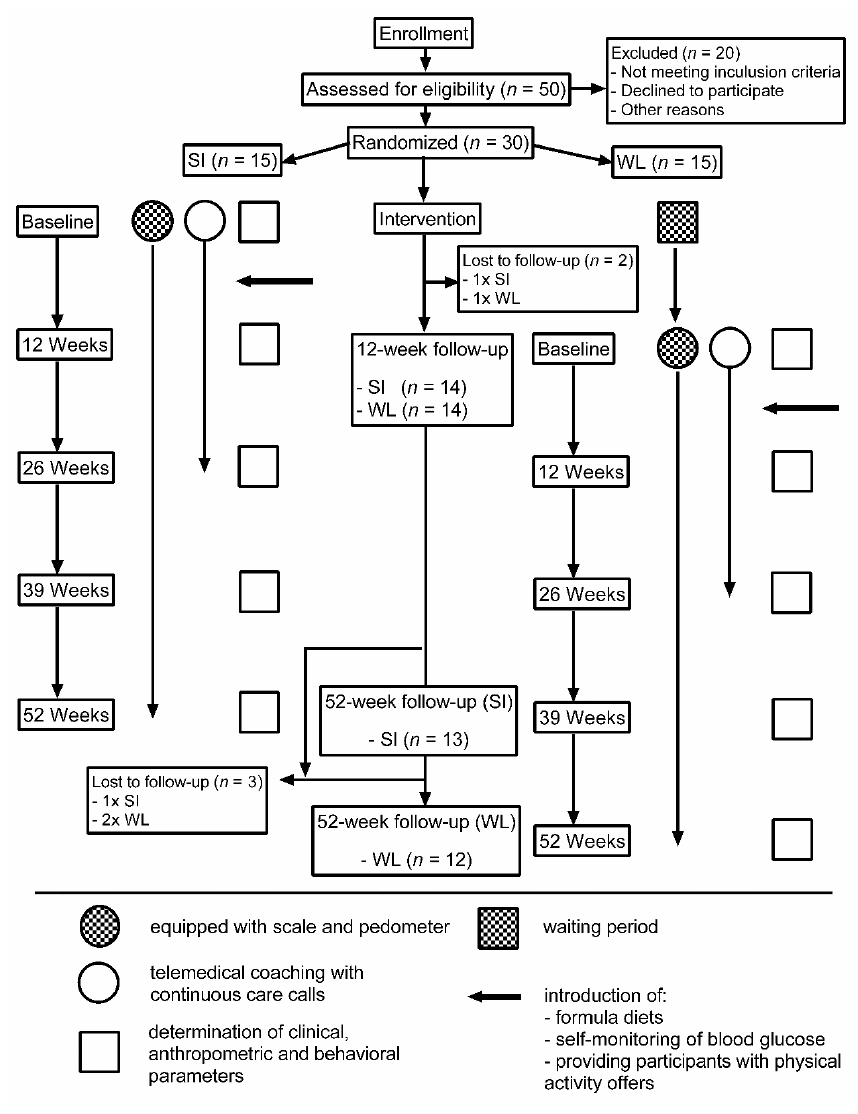
Figure 1. Flow diagram. SI, starting intervention group; WL, waiting list control group.